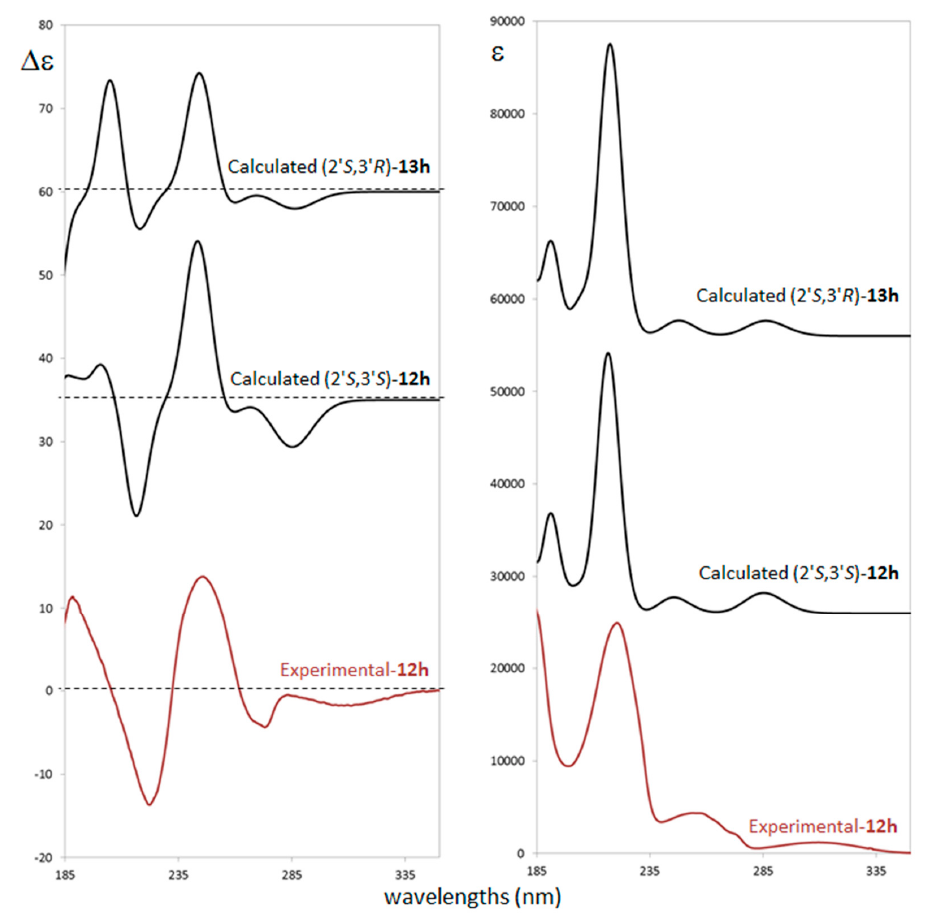
Figure 2. Comparison of experimental and computed electronic circular dichroism (ECD) ( left ) and ultraviolet (UV) ( right ) spectra for the different ACs for compounds trans - 12h (experimental and calculated) and cis - 13h (calculated).